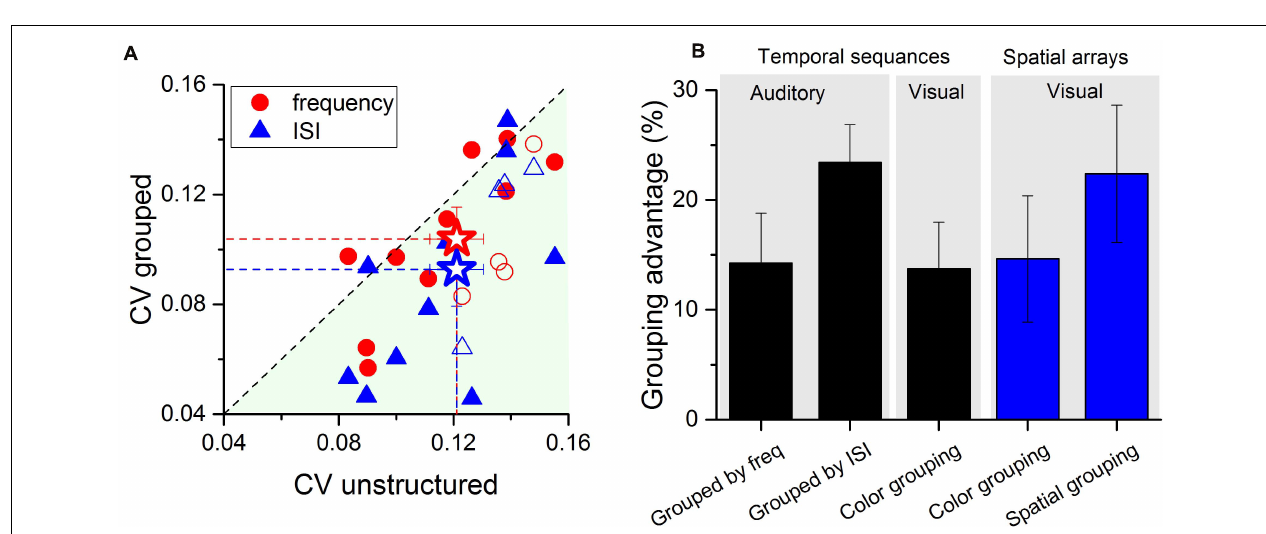
FIGURE 3 | Groupitizing affects precision of estimation of auditory stimuli. (A) Average Coefficient of variation as a function of numerosity for the three experimental conditions (black squares: unstructured stimuli, red circles: stimuli grouped by frequency, blue triangles: stimuli grouped by ISI). (B) Coefficients of variation averaged across numerosity levels and participants. Black Error bars show ± 1 SEM.